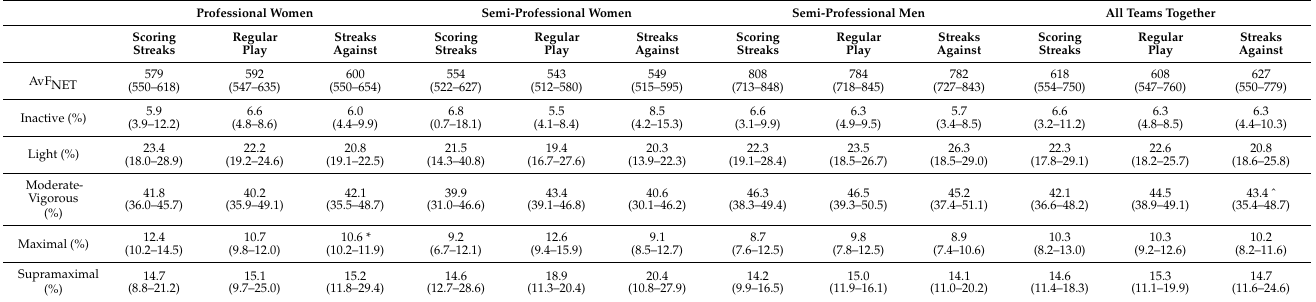
Table 2. On-court activity intensity during scoring streaks, streaks against and regular play for each team and for all teams combined.